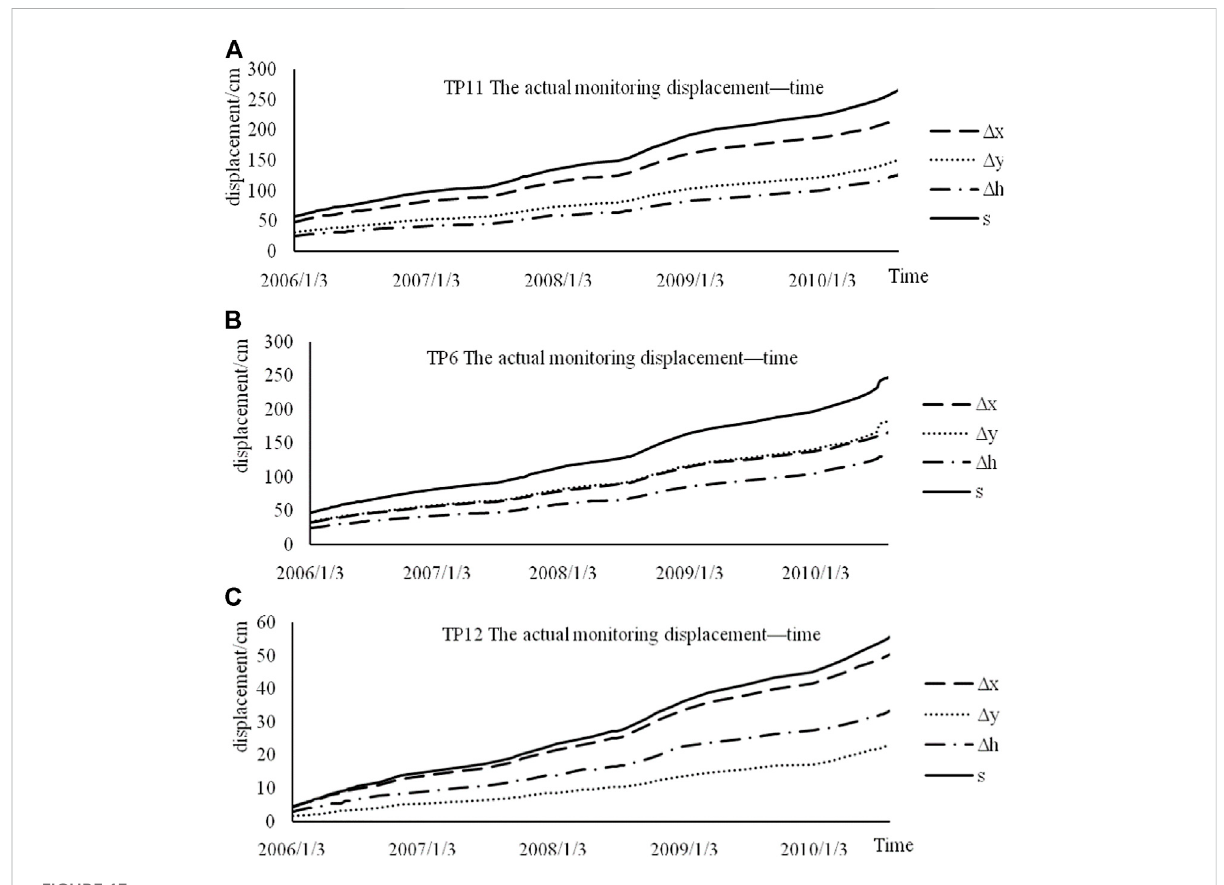
FIGURE 13 Monitoreddisplacement – timegraph. (A) TP11,theactualmonitoreddisplacement – time. (B) TP6,theactualmonitoreddisplacement – time. (C) TP12, the actual monitored displacement – time.